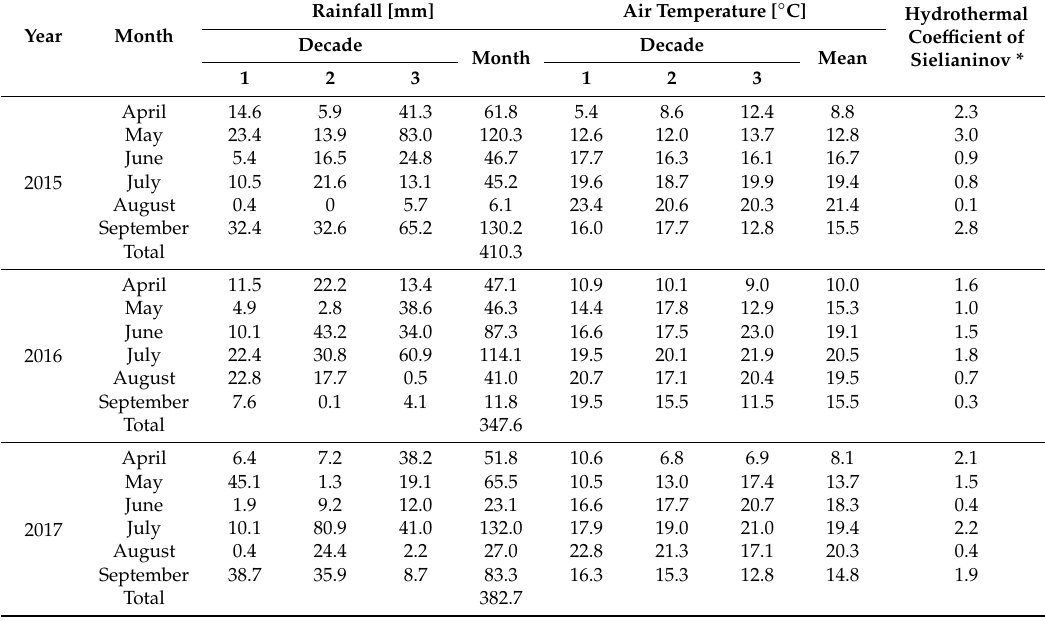
Table 4. Meteorological conditions in the season of potato vegetation in